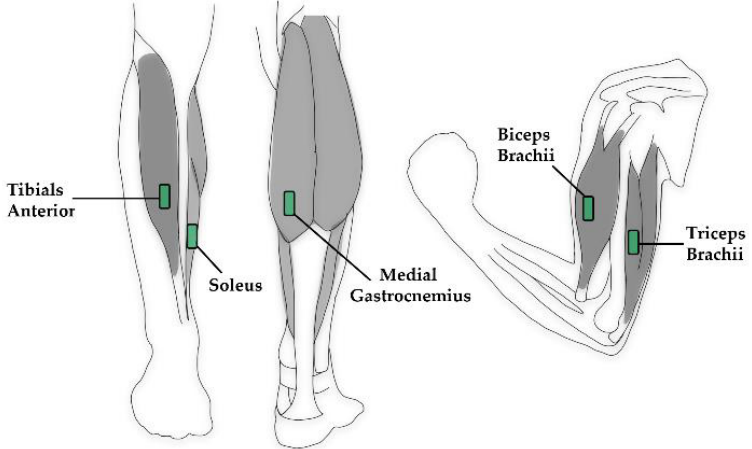
Figure 2. Illustration of surface electromyograph (sEMG) sensor (green) placement. For the lower limbs, the sensors were placed on the weight-bearing leg on the tibialis anterior, soleus, and medial gastrocnemius. For upper body limbs, the sensors were bilaterally placed on the biceps brachii and triceps brachii. All sensors were placed according to SENIAM recommendations [24] .